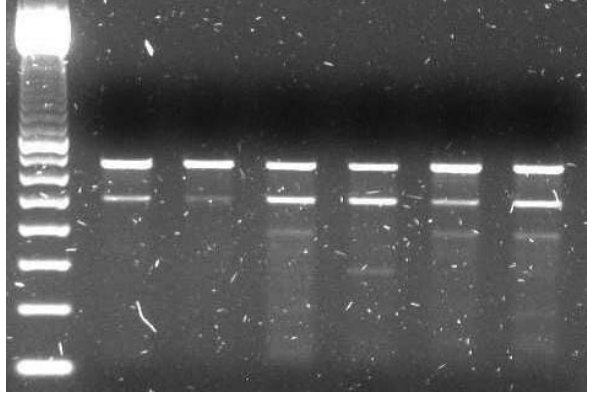
Figure 4 - PIT1 cDNA amplicons. First lane - 100 bp ladder of molecular weight markers. Lanes 1 and 2 - genotype AB; lanes 3 and 4 - genotype BB; lanes 5 and 6 - genotype AA. The samples were run on 2% agarose gels.